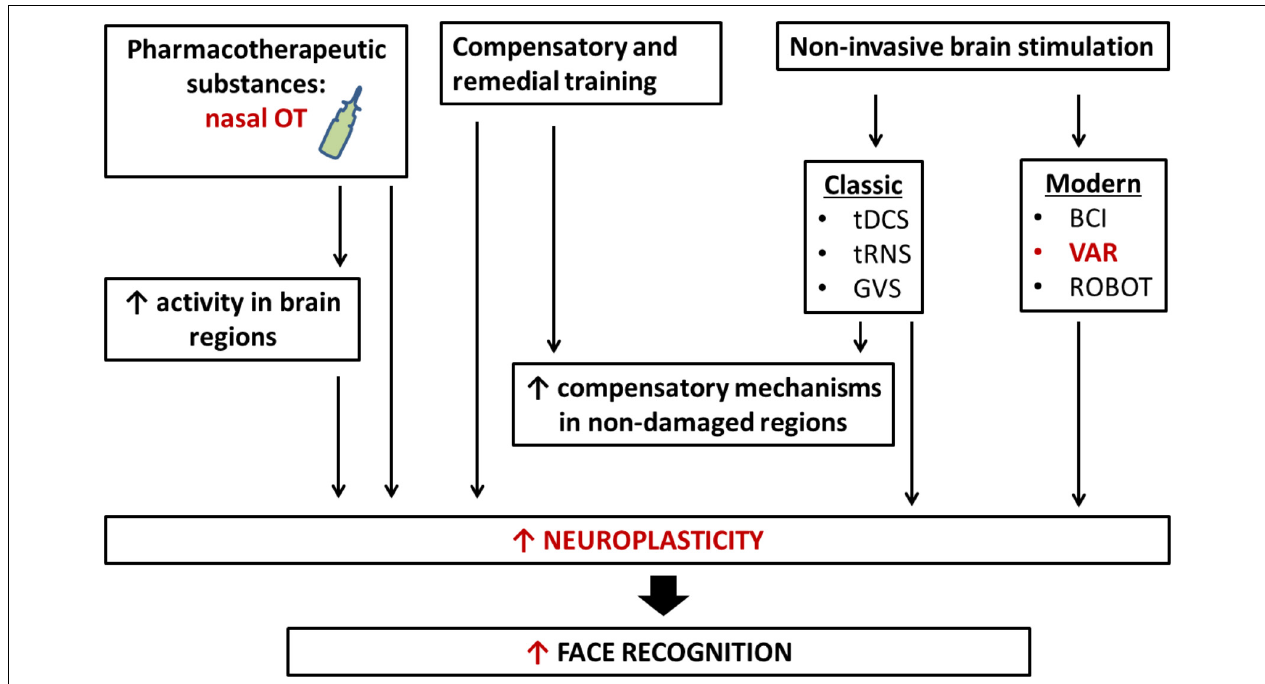
FIGURE 3 | New neurotechnology for rehabilitation of face recognition. Rehabilitation of face recognition includes compensatory and remedial training, the administration of pharmacotherapeutic substances, classic and modern non-invasive brain stimulations, and interaction with robots. The application of more than one technique simultaneously may bring about larger and longer-term benefits. tDCS, transcranial direct current stimulation; tRNS, transcranial random noise stimulation; GVS, galvanic vestibular stimulation; VAR, virtual/adapted reality; BCI, brain–computer interface; OT,